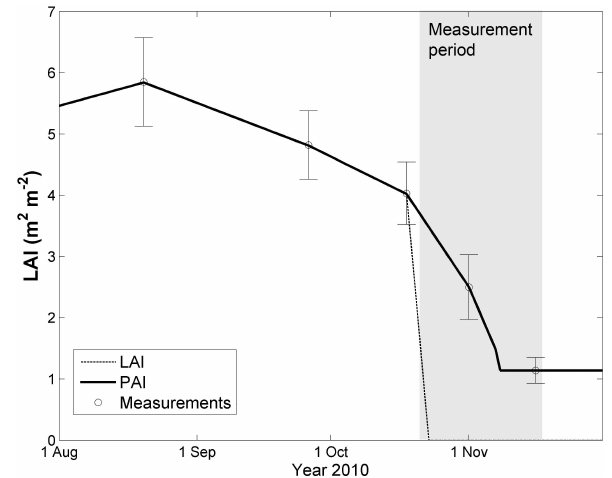
Fig. 1. Plant area index (PAI) and leaf area index (LAI) of Lille Bøgeskov for autumn 2010. Open circles show the LAI-2000 mea- surements of PAI with the standard deviations indicated by the er- ror bars. Daily values of PAI (solid line) and of LAI (dotted line) are found from linear interpolation. The grey rectangular area shows the ammonia (NH 3 ) measurement period (21 October to 15